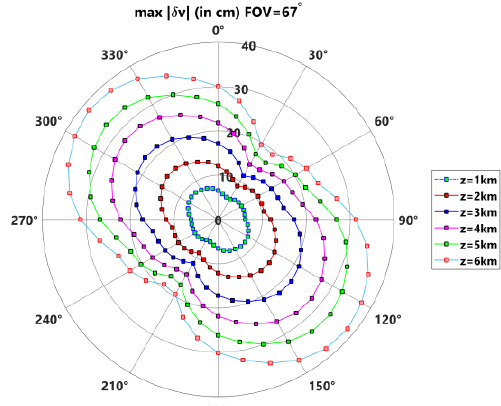
Figure 8. Impact of azimuth-angle variations on vertical coordinates ( v  ) using SWEN17 model at different flight altitudes assuming FOV=67 ̊ in Sweden (the polar plots show maximum absolute value of v  ). Unit: cm